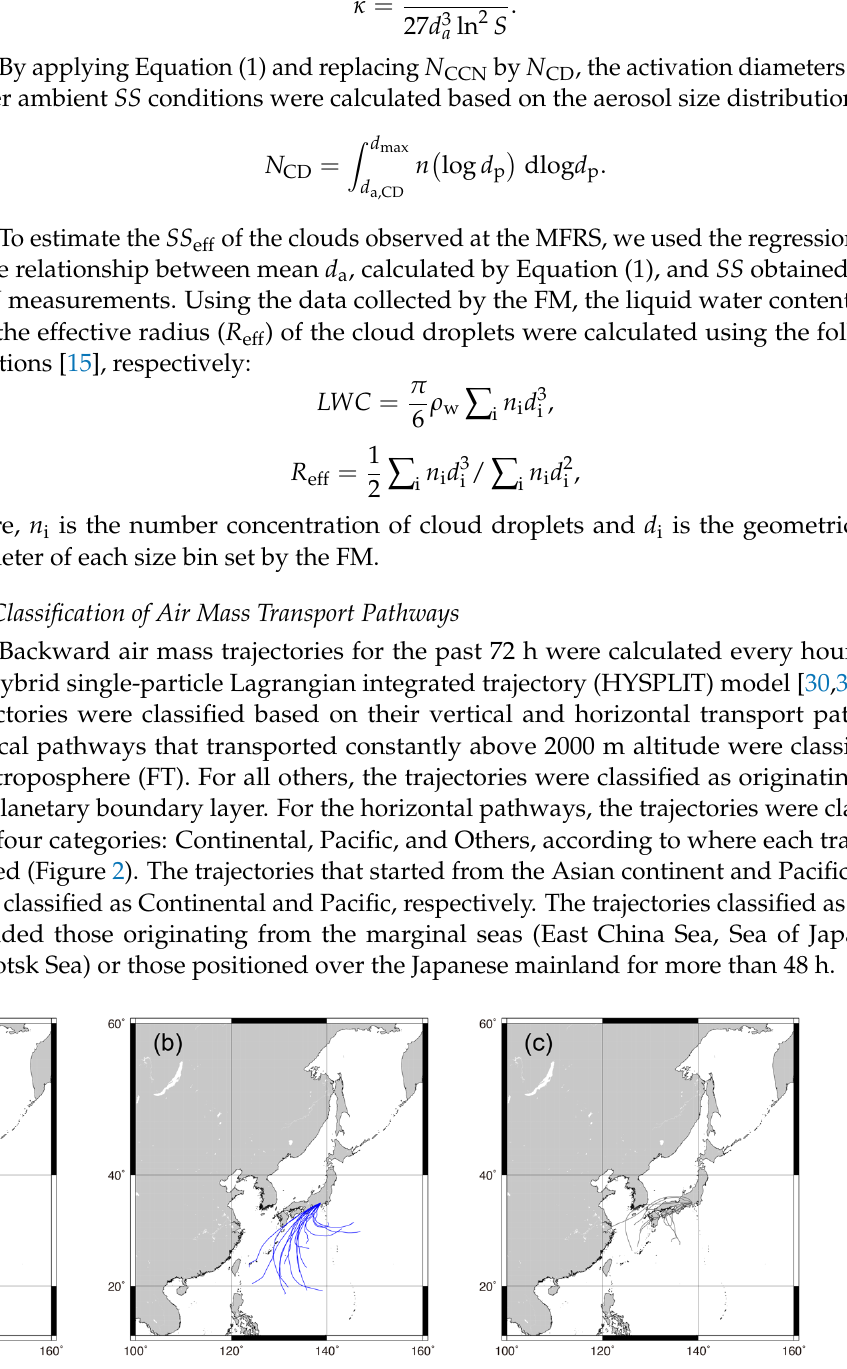
Figure 2. Examples of trajectories classified ( a ) Continental, ( b ) Pacific and ( c ) Others. For the vertical pathways, only trajectories classified as free troposphere (FT) are illustrated.